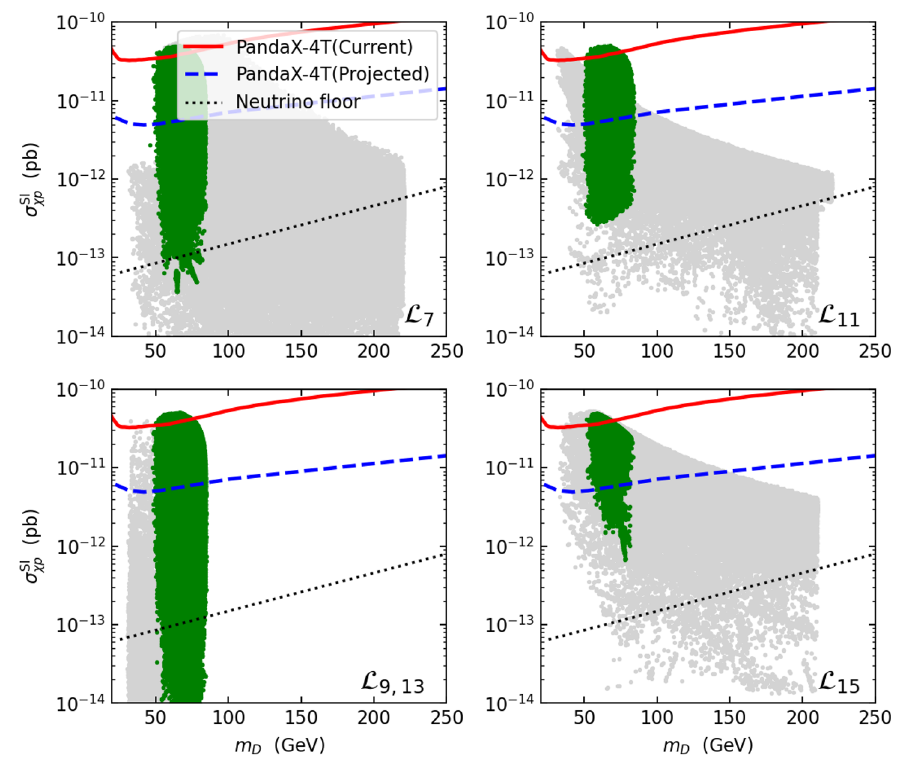
) plane. The red solid lines are current PandaX-4T Figure 7 . The 2 σ distribution on the ( m D , σ SI χp 90% upper limit [32], the blue dashed lines are expected PandaX-4T 90% upper limit [61], and the black dotted lines are neutrino floor [62]. The color coding is same as figure